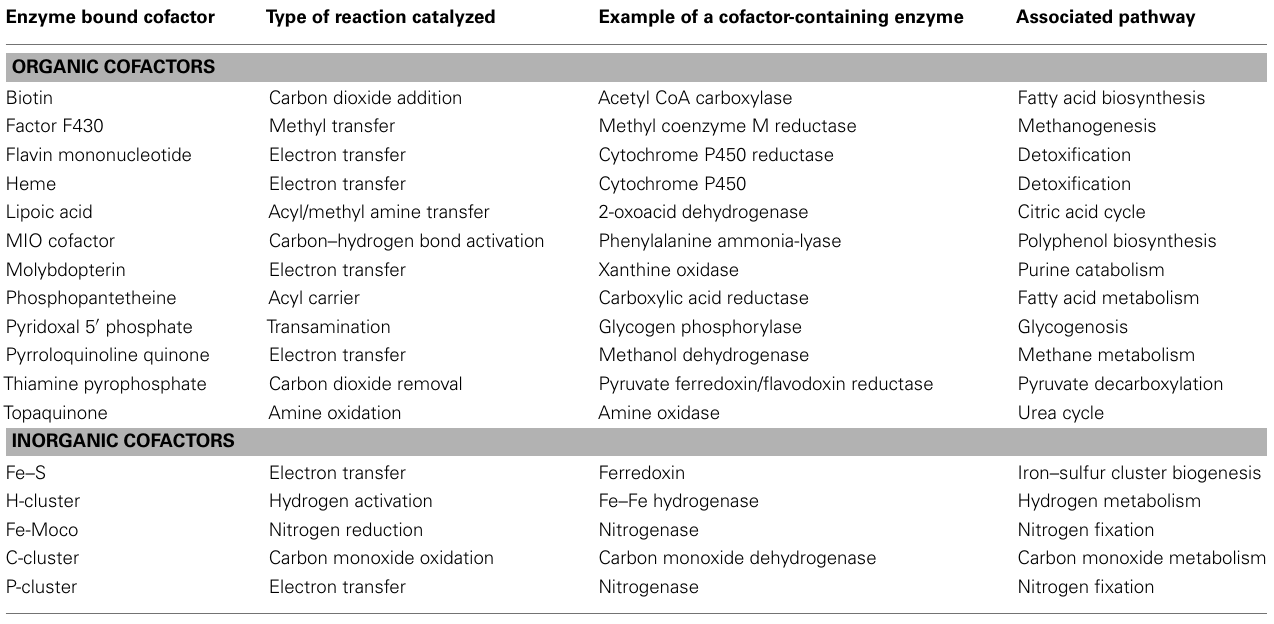
Table 1 | Examples of enzyme bound cofactors .